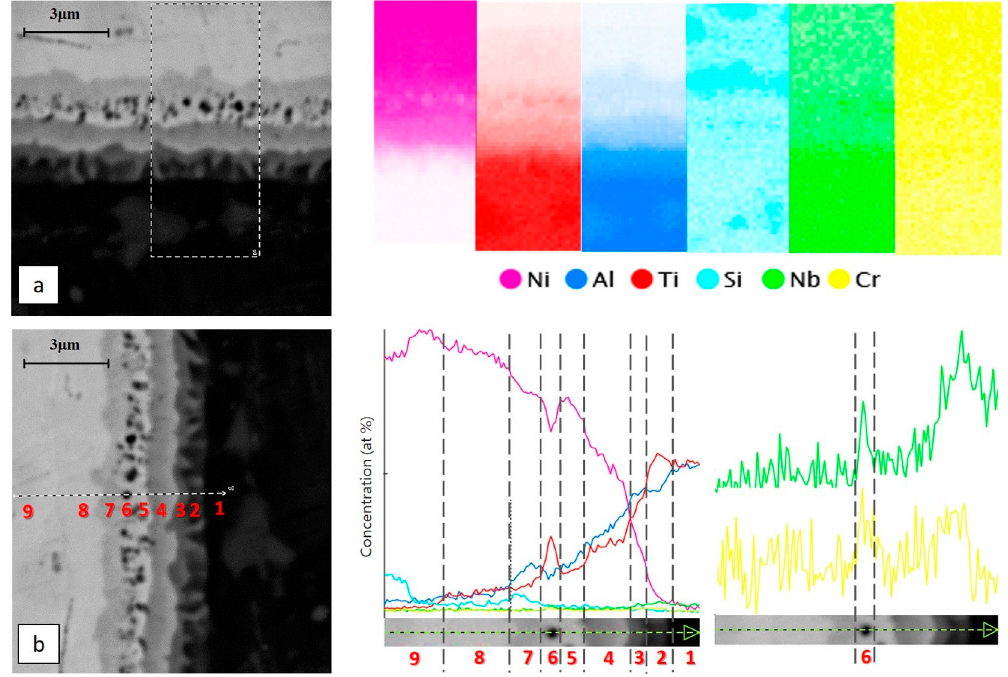
Figure 4. ( a ) EDS map along the TiAl-Ni base filler interface; ( b ) EDS